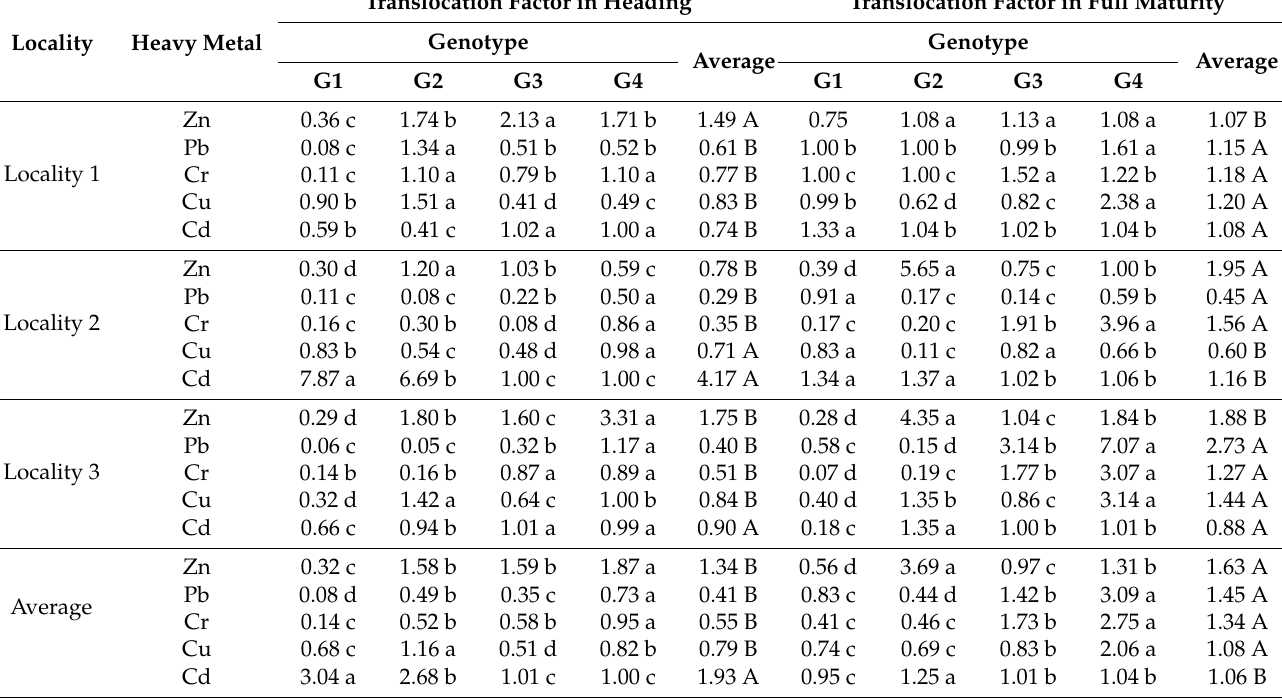
Table 5. The translocation factor in different phenophases of analyzed wheat genotypes (G1—Pobeda; G2—Ljiljana; G3—Renesansa; and